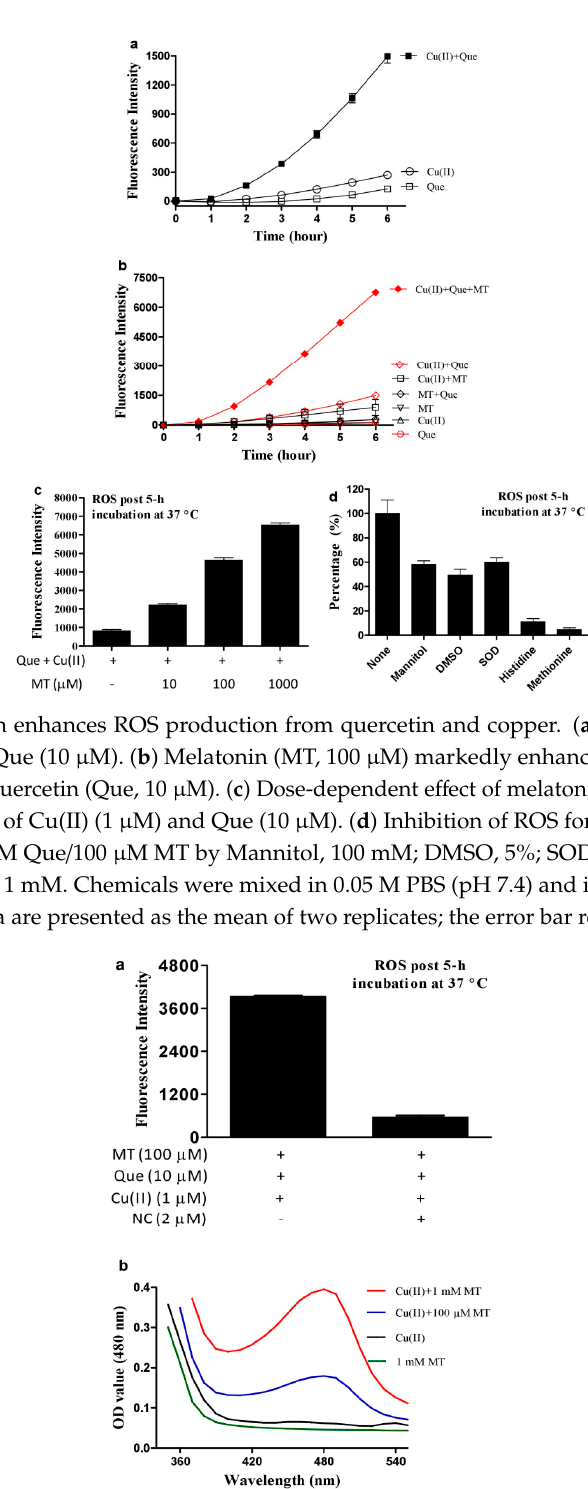
Figure 2. Role of copper (I) for synergistic production of ROS and the influence of melatonin on copper (I) formation. ( a ) Effect of neocuproine (NC) on ROS production in the system of Cu(II), quercetin (Que) and melatonin (MT). Data are presented as the mean of two replicates. ( b ) Detection of MT-induced Cu(I) production by BCS. Reaction mixture contained 50 μ M Cu(II) and 0.3 mM BCS in 0.05 M PBS (pH 7.4) and indicated concentrations of MT, and was incubated at 37 °C for 30 min.